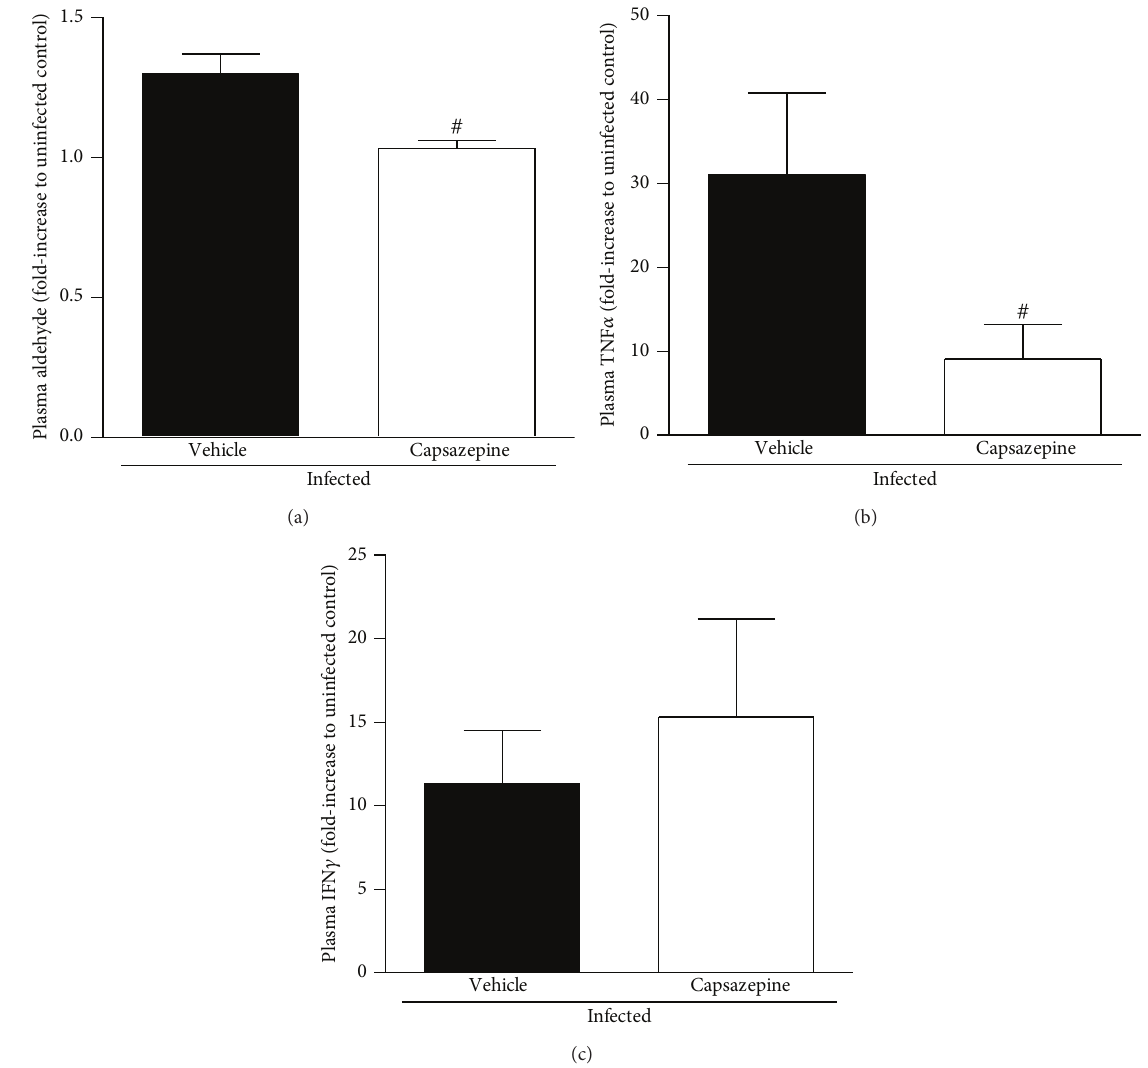
Figure 6: Effect of capsazepine on systemic lipid peroxidation and cytokine release. (a) Aldehyde; (b) TNF 𝛼 and (c) IFN 𝛾 levels in plasma samplesobtainedfromuninfectedand Plasmodiumberghei ANKA-infectedmice(10 5 infectedRBCs/animal;i.p.).Capsazepine(50 𝜇